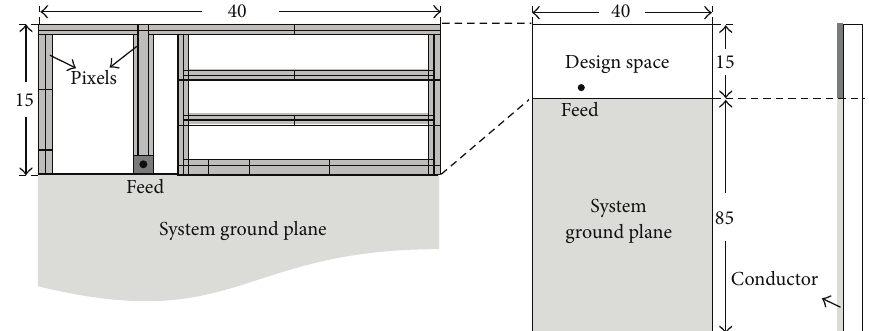
Figure 10: Geometry of the mobile antenna for handheld devices and the discretization of the design space (unit: mm).